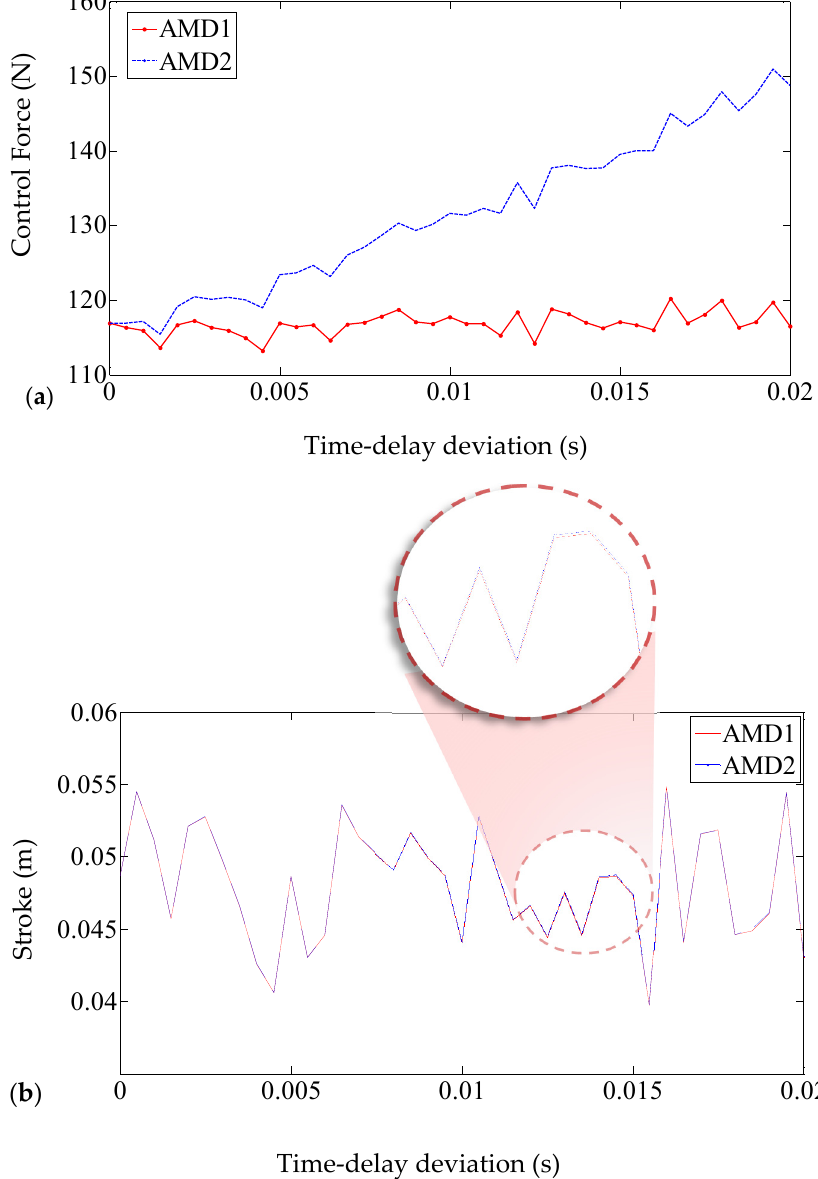
Figure 9. The control parameters of System2 with different time-delay deviations, ( a ) the control forces and ( b ) the strokes.